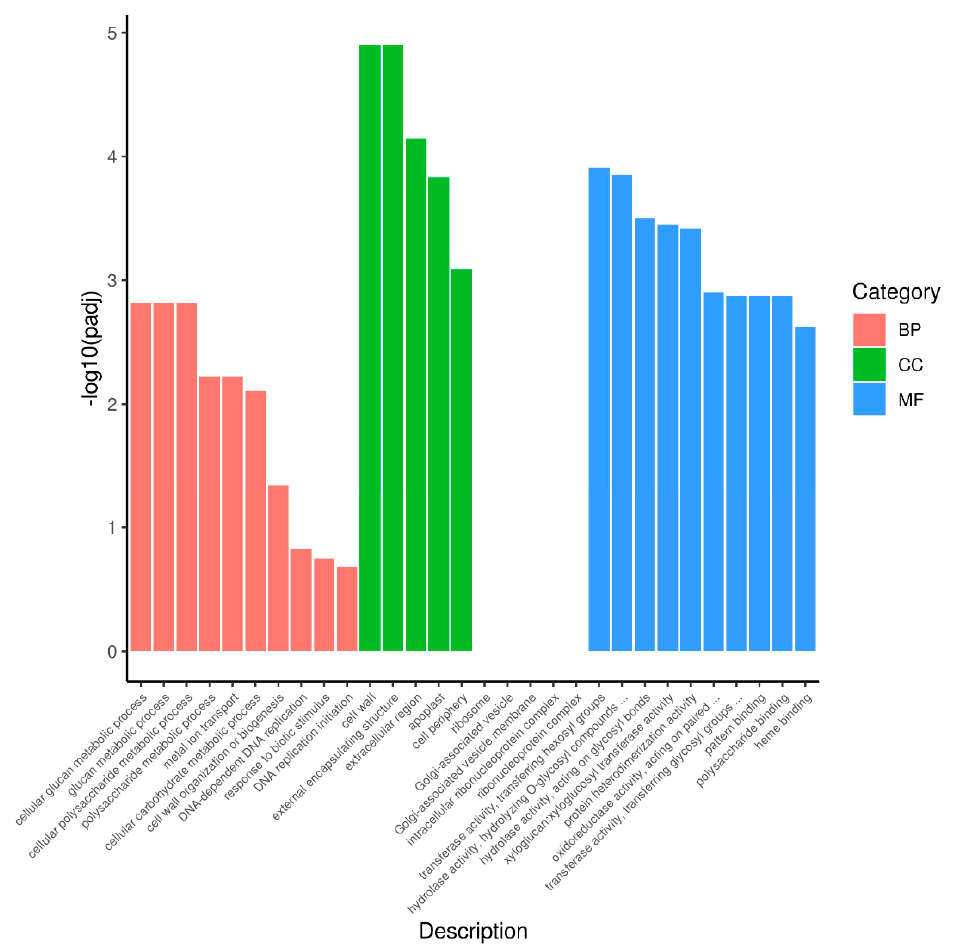
Figure 4. GO enrichment analysis of the DEGs between purple non-heading Chinese cabbage and its green mutant. BP, CC, and MF indicate the biological process, cellular component, and molecular function, respectively.